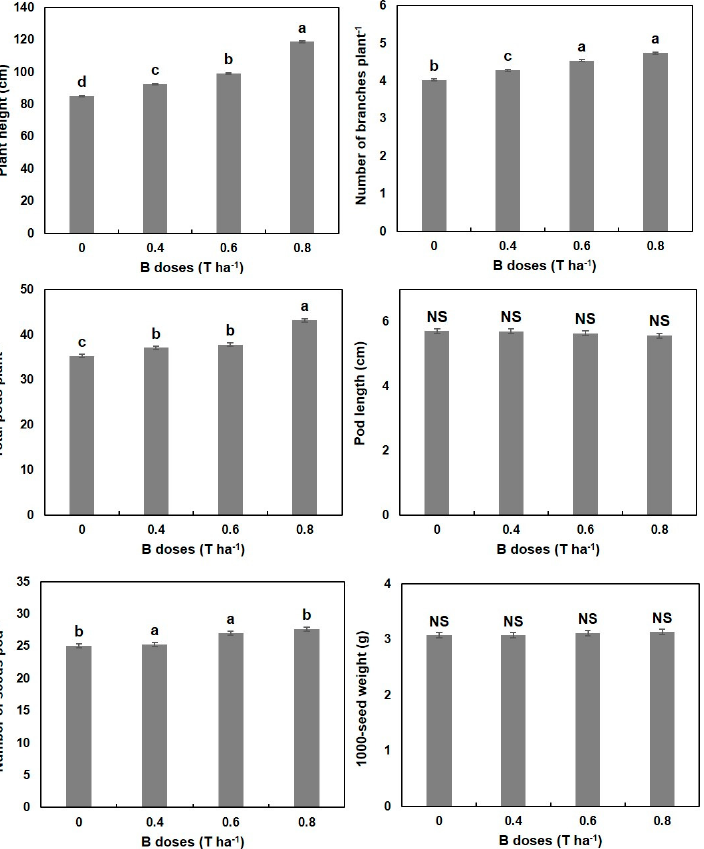
Figure 3. B’s impact on plant height, branches plant − 1 , pods plants − 1 , pod length, seeds pods − 1 and 1000-seed weight of Mustard. Figures with same letter (s) or without letter do not differ significantly, whereas figures with dissimilar letters differ significantly as per DMRT. NS = Not significant.